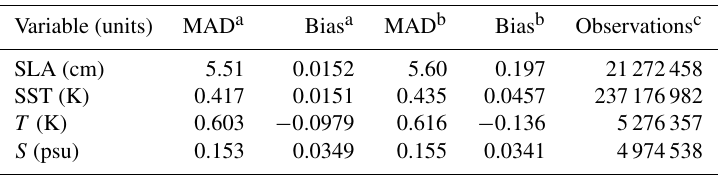
Table 2. Global mean and 7-day mean forecast innovation mean absolute deviation (MAD) and bias for sea-level anomaly (SLA), sea surface temperature (SST), subsurface temperature ( T ) and salinity ( S ) from a series of forty-four 7-day forecasts, 3 days apart from 3 January 2013. See Fig. 2 for information on how the base dates are aligned.